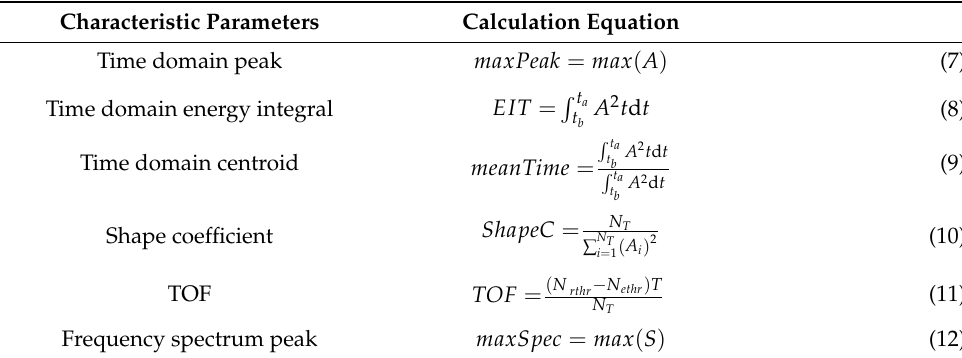
Table 1. “Point” characteristic parameters of UGW